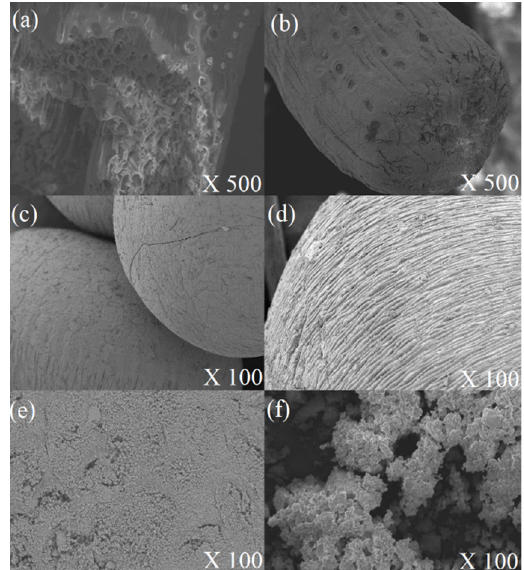
Figure 6. Scanning electron microscopy (SEM) image. Supports/Immobilized biocatalysts by covalent binding (CB): coconut fiber ( a ); coconut fiber-CB ( b ); calcium alginate microspheres ( c ); calcium alginate microspheres-CB ( d ); SBA-15/albumin hybrid ( e ); SBA-15/albumin-CB ( f ).